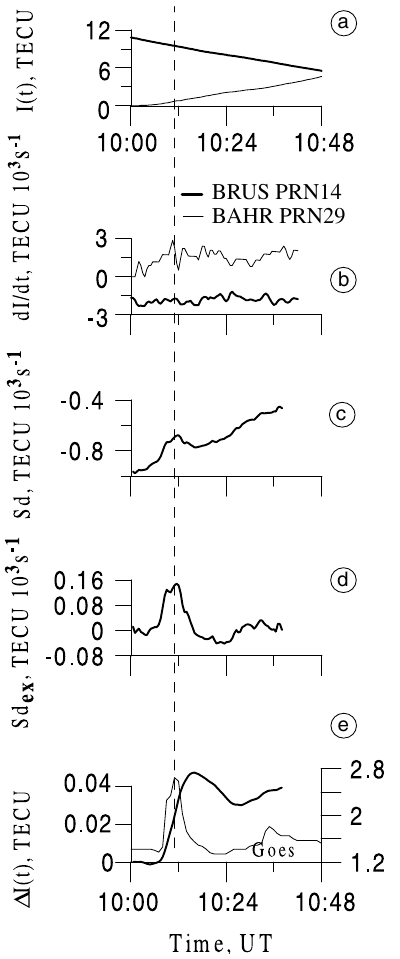
Fig. 1a-e. Faint solar flare July 29, 1999 (C2.5/SF, 10:11 UT, S16W11). The typical time dependencies of TEC variations for separate LOS (a) and their time derivatives (b) for stations BRUS (PRN14, thick line) and BAHR (PRN29, thin line); a normalized result of a coherent summation Sd of the time derivatives of the TEC variations for all LOS (c); the same curve (c), upon subtracting the trend determined as a polynomial of degree 3 on the time interval 10:07- 10:19 UT (d); mean integral increment of TEC (thick line) and soft X-ray emission flux (GOES-10) in the range 1-8 Å (thin line)